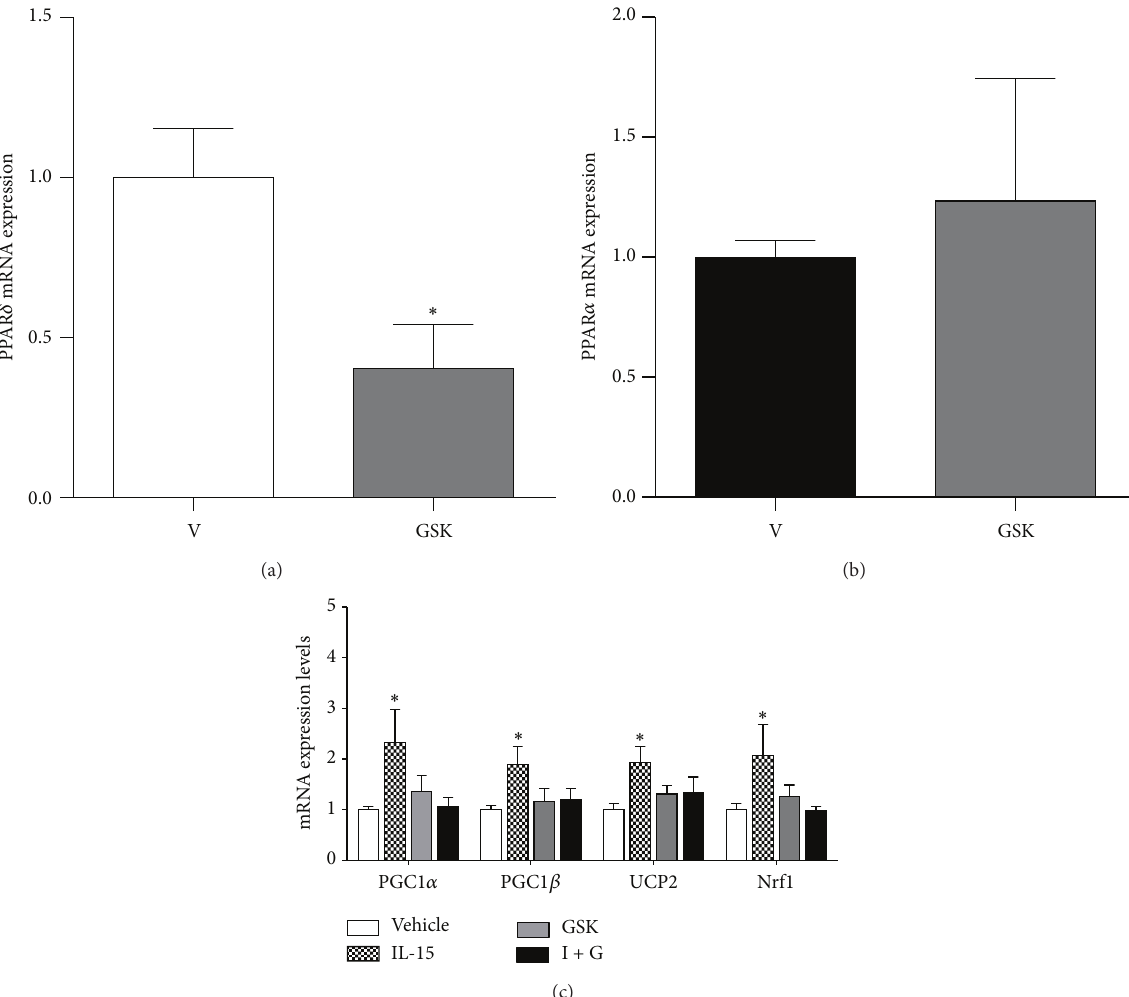
Figure 5: Effects of PPAR 𝛿 inhibition on IL-15 mediated alterations of mitochondrial associated factors. (a) mRNA expression of PPAR 𝛿 following inhibition with GSK-3787 (GSK); (b) mRNA expression of PPAR 𝛼 following exposure to GSK; (c) mRNA expression of PGC1 𝛼 , PGC1 𝛽 , UCP2, and Nrf1 with IL-15 treatment in combination with GSK. Throughout differentiation, cells were treated every other day, for 6 days, with either vehicle control (DMSO), IL-15 (100 ng/mL), 1 𝜇 M of the PPAR 𝛿 inhibitor (GSK-3787), or IL-15 + GSK-3787 (I + G). GAPDH was used as an internal control for qPCR analysis. All values are displayed as means ± SEM, 𝑛 = 6–9 per group, ∗ different from all groups; 𝑃 < 0.05